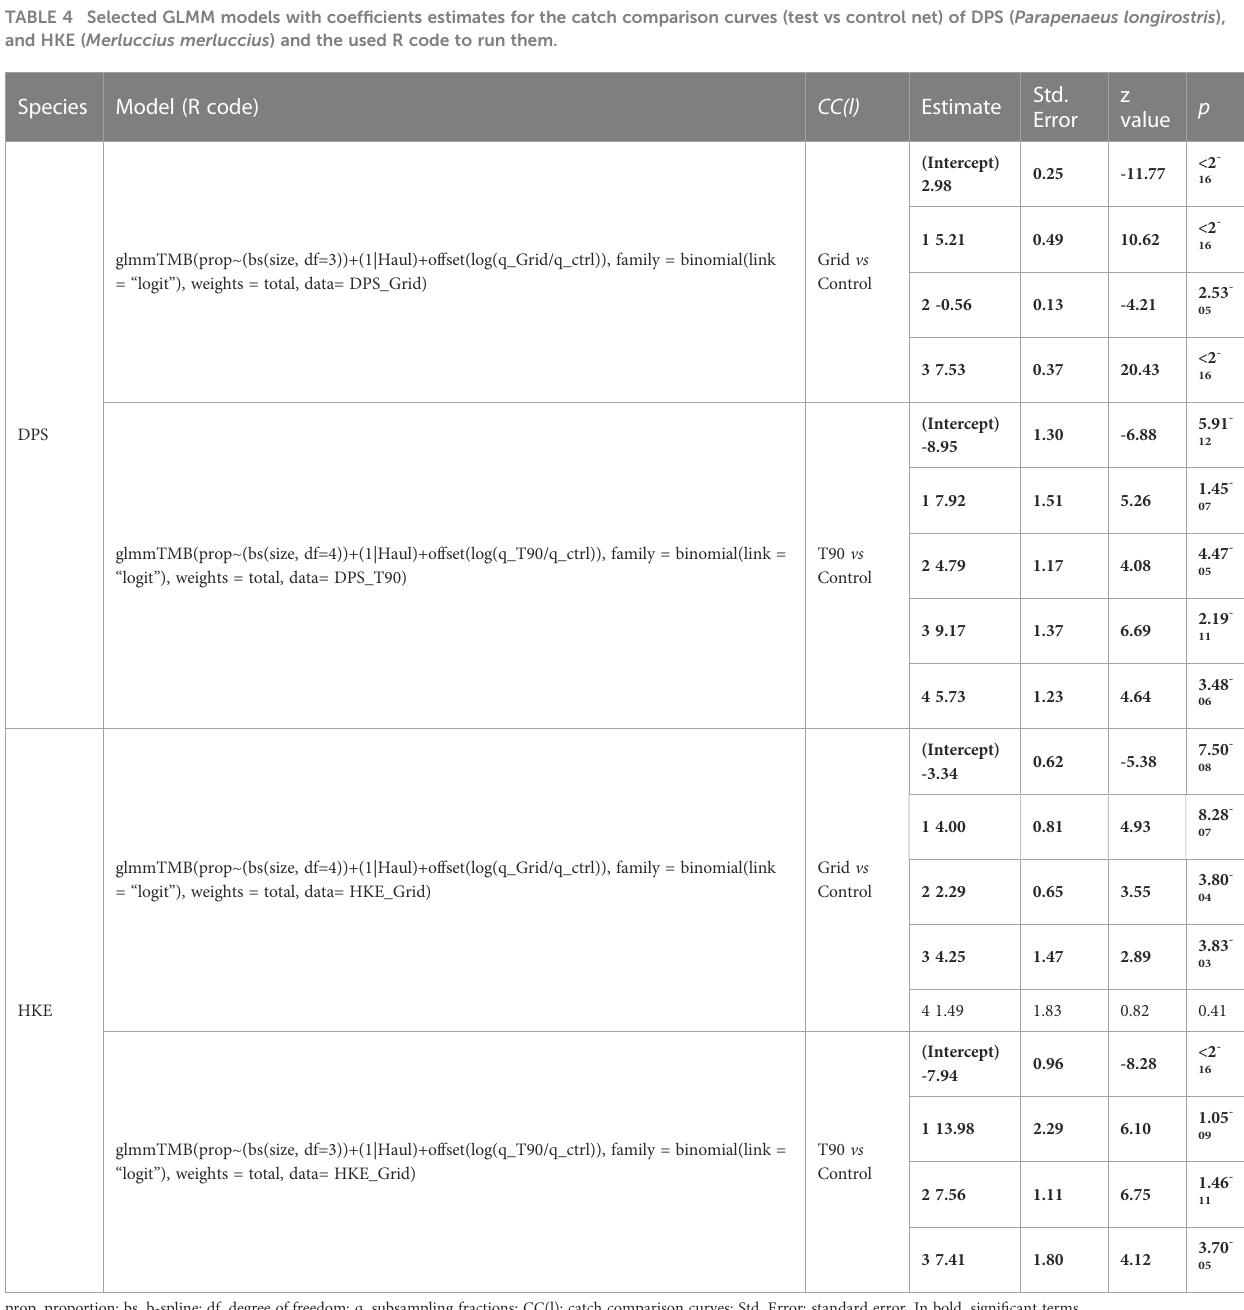
TABLE 4 Selected GLMM models with coef fi cients estimates for the catch comparison curves (test vs control net) of DPS ( Parapenaeus longirostris ), and HKE ( Merluccius merluccius ) and the used R code to run them. Species Model (R code) CC(l) Estimate